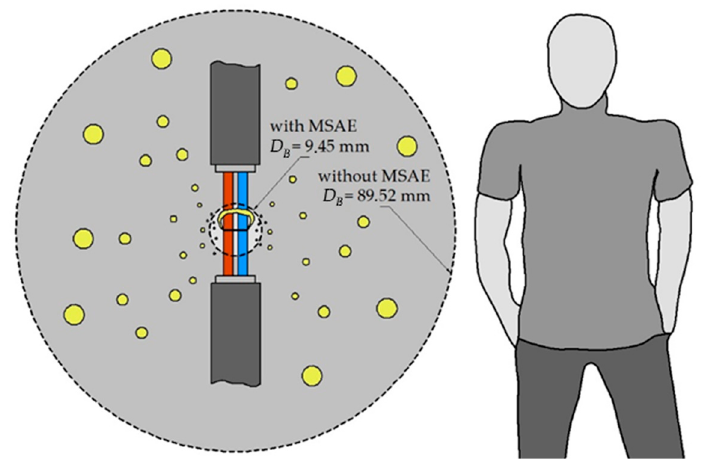
Figure 14. The emergency arc damage zone with MSAE (MSAE ON) and without MSAE (MSAE